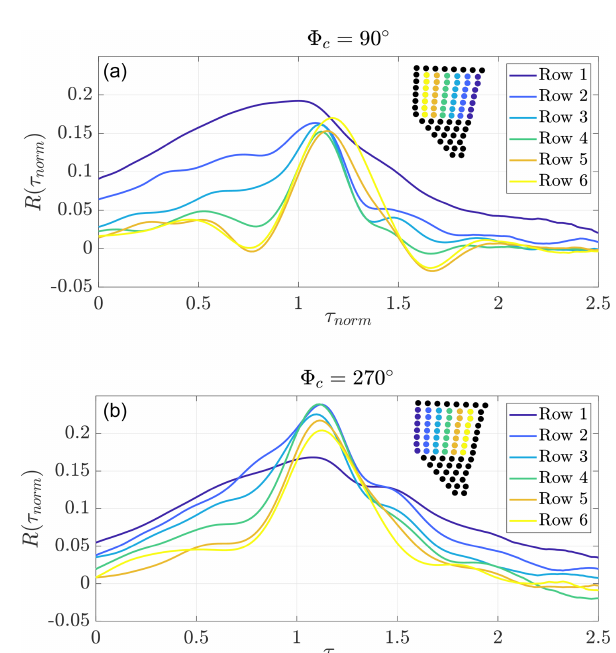
Figure 6. Averaged power output fluctuation correlation per wind farm row for wind direction intervals around 90 ◦ (a) and 270 ◦ (b) considering all wind turbines in the symmetric square (see Fig. 1). (cid:56) c depicts the centre of the wind direction intervals. For the consid- ered correlation curves, wind turbine A is located in the respective coloured row and turbine B is one row downstream of A. As the wind turbines are analysed in pairs of two, the last row of wind turbines is unlabelled, as these wind turbines do not have a down- stream partner. For both figures, the numbering and the colours of the rows are identical with regard to the considered wind direction.